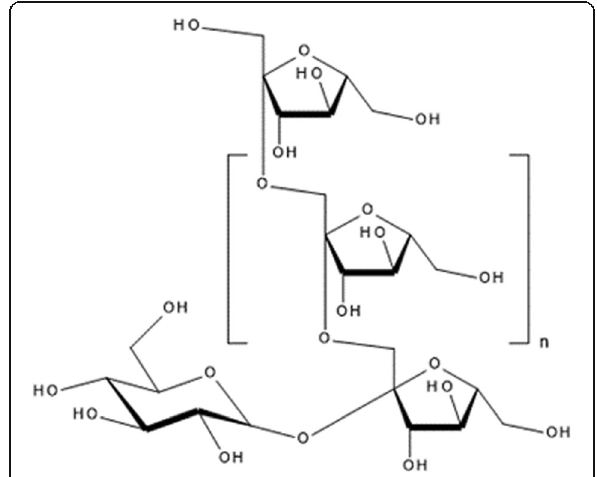
Fig. 1 Chemical structure of inulin, drawn by BIOVIA